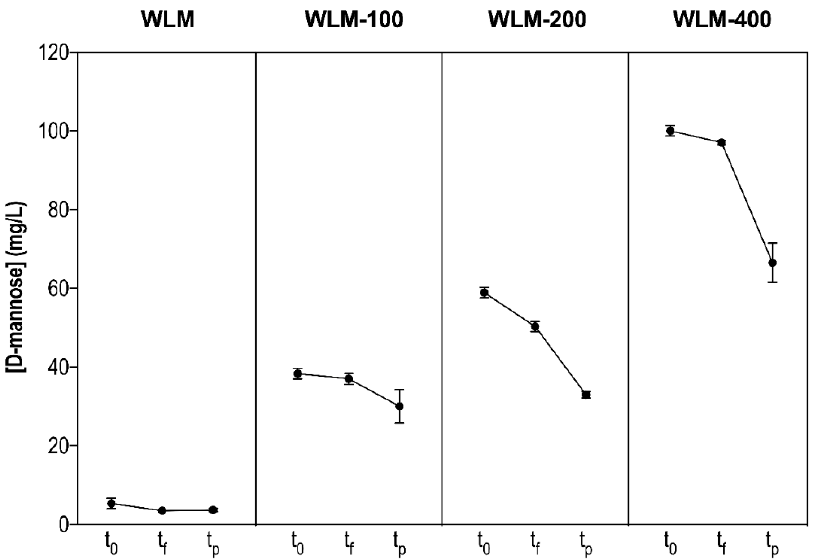
Figure 1. Mannoprotein concentration (mg of mannose eq./L) in wine-like medium (WLM) with mannoprotein extract addition throughout malolactic fermentation of O. oeni PSU-1. WLM-100, -200, and -400 represent the concentration (mg/L) of commercial mannoprotein extract added. t 0 , t f , and t p represent before O. oeni inoculation, at the end of MLF ((L-malic acid) < 0.1 g/L), and after MLF (3 days after completion of MLF), respectively.